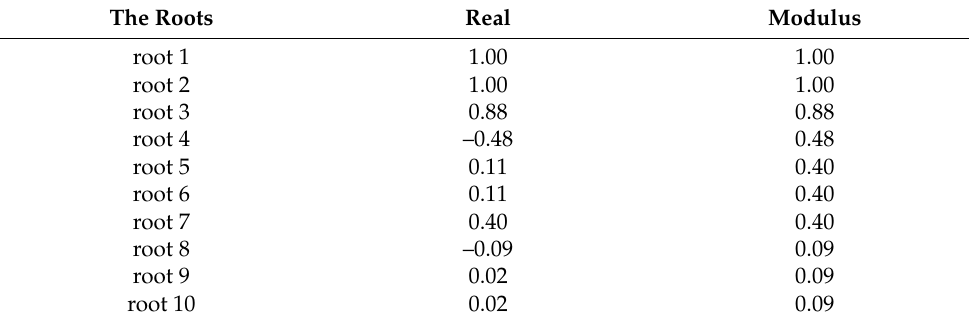
Table A1. The unit roots of the VAR(3)